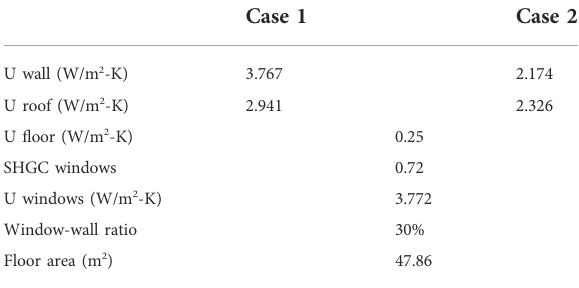
TABLE 1 Thermal properties for case studies.